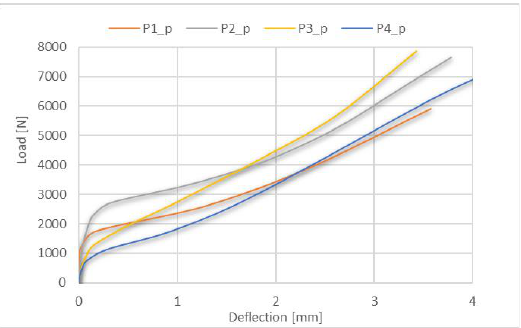
Figure 12. Postbuckling equilibrium paths for perforated profiles with all tested lay-ups.